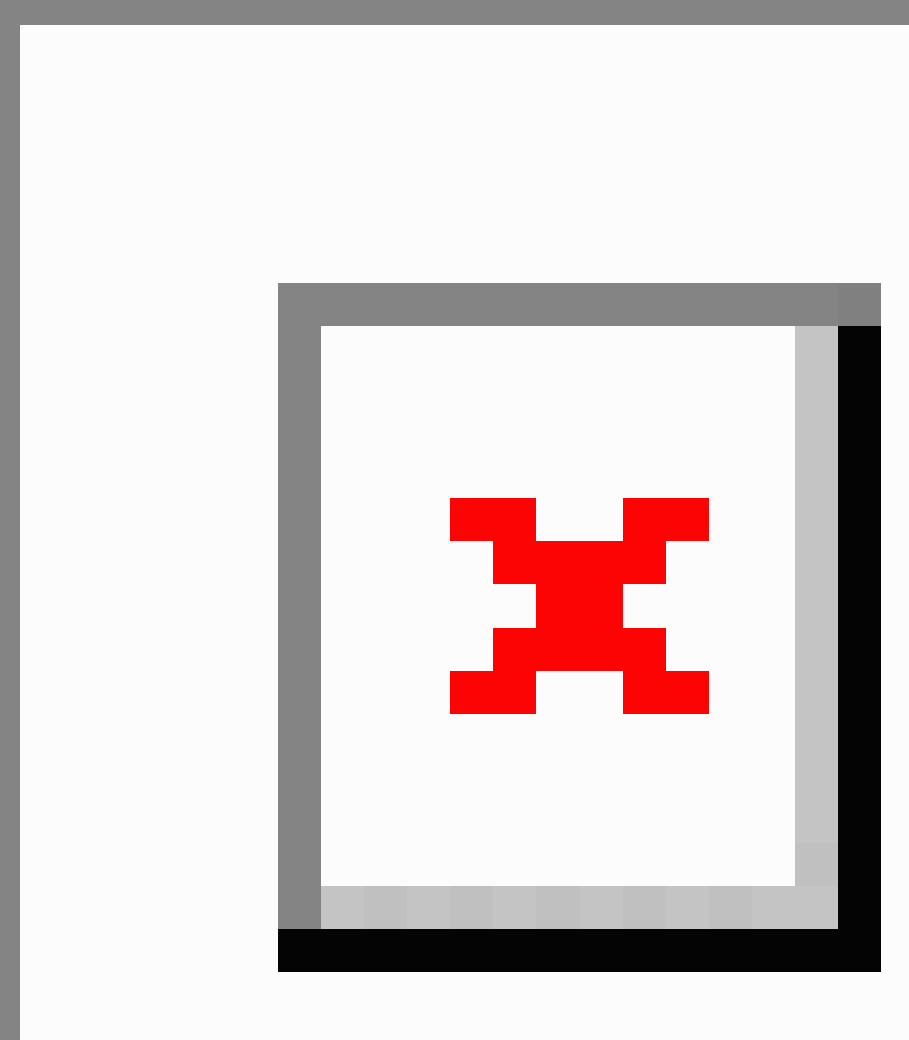
Figure 1. Procedure for selecting Chinese smoking cessation